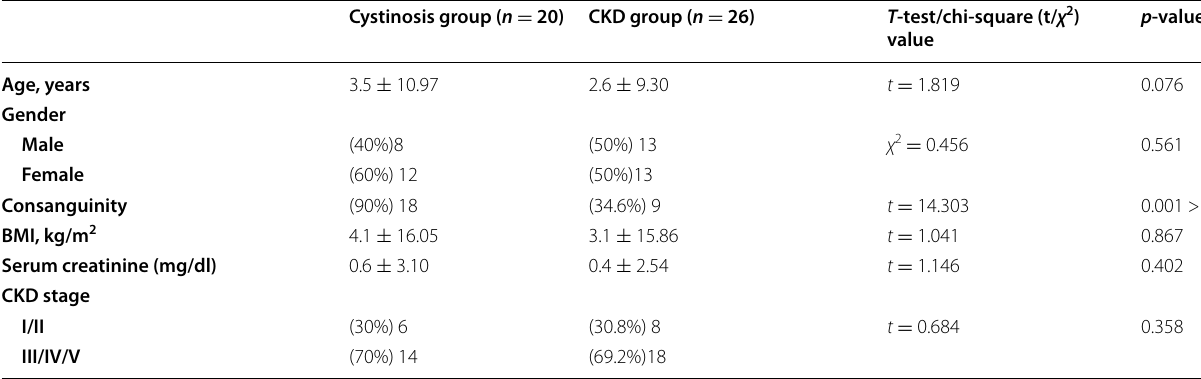
Independent t -test was used to compare difference in mean between groups (t). Chi-square test was used to compare the difference in frequencies among groups ( χ 2 ). CKD , chronic kidney disease; BMI , body mass index Table 2 Comparison between cystinosis and CKD groups regarding Stanford-Binet test (SB)